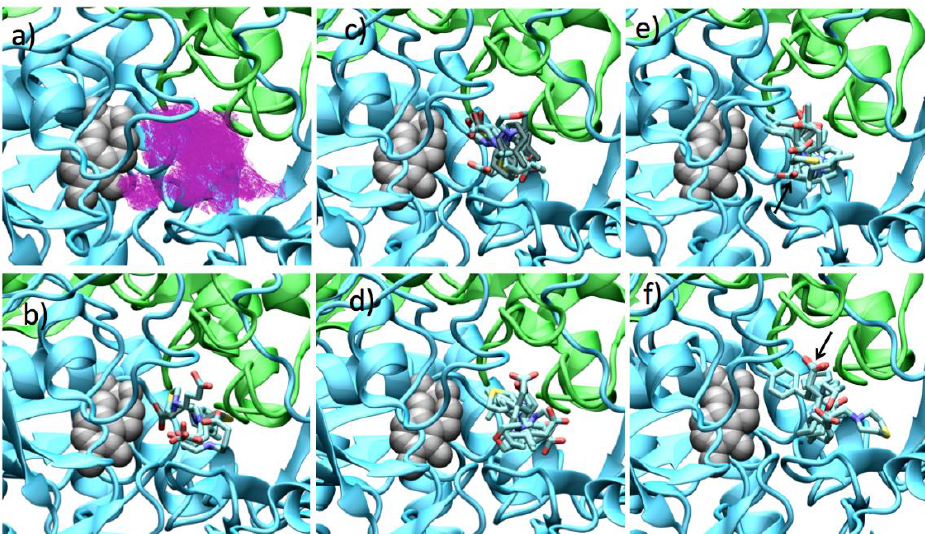
Figure 10. Docking results over Pseudomonas fluorescens GABA-AT catalytic site. ( a ) Cavity form (magenta color mesh representation) of the GABA-AT catalytic site. ( b ) GABA analogues 7 . ( c ) ( S )-Pregabalin analogues 8 . ( d ) ( R )-Pregabalin analogues 8 . ( e ) ( S )-Baclofen analogues 9 . The best compound ( 9b ) is indicated by an arrow. ( f ) ( R )-Baclofen analogues 9 . The best compound ( 9b ) is indicated by an arrow. PLP prosthetic group is showed as gray Van der Waals spheres and each protein chain is colored in green and cyan. The compounds where the carboxylic acid moiety is oriented to PLP are colored in obscure .